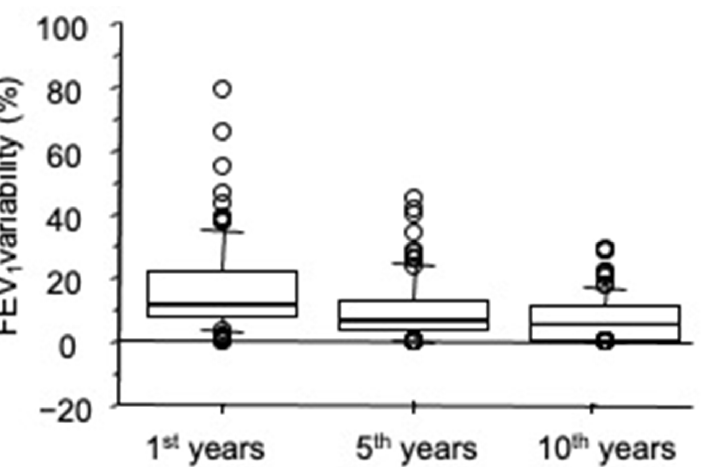
Figure 6. FEV 1 variability (in percent of predicted), separately for 1st, 5th, and 10th years. Bars indicate (from the bottom to the top) 10th, 25th, 50th (median), 75th, and 90th percentiles. Values below 10th and above 90th percentiles are plotted as circles. Significant differences were found between 1st and 5th years, between 1st and 10th years and between 5th and 10th years (Wilcoxon test).